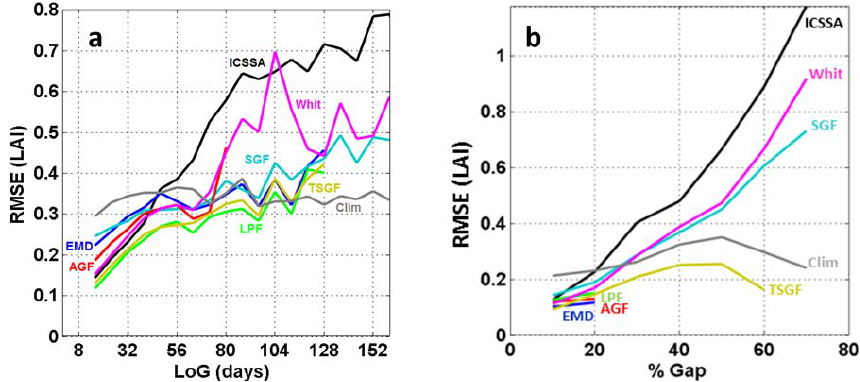
Fig. 8. RMSE as a function of the length of gaps (a) and fraction of missing observations (%gap) (b) . The RMSE is computed between LAI ref and the reconstructed LAI rec time series over dates with missing observations in LAI sim .